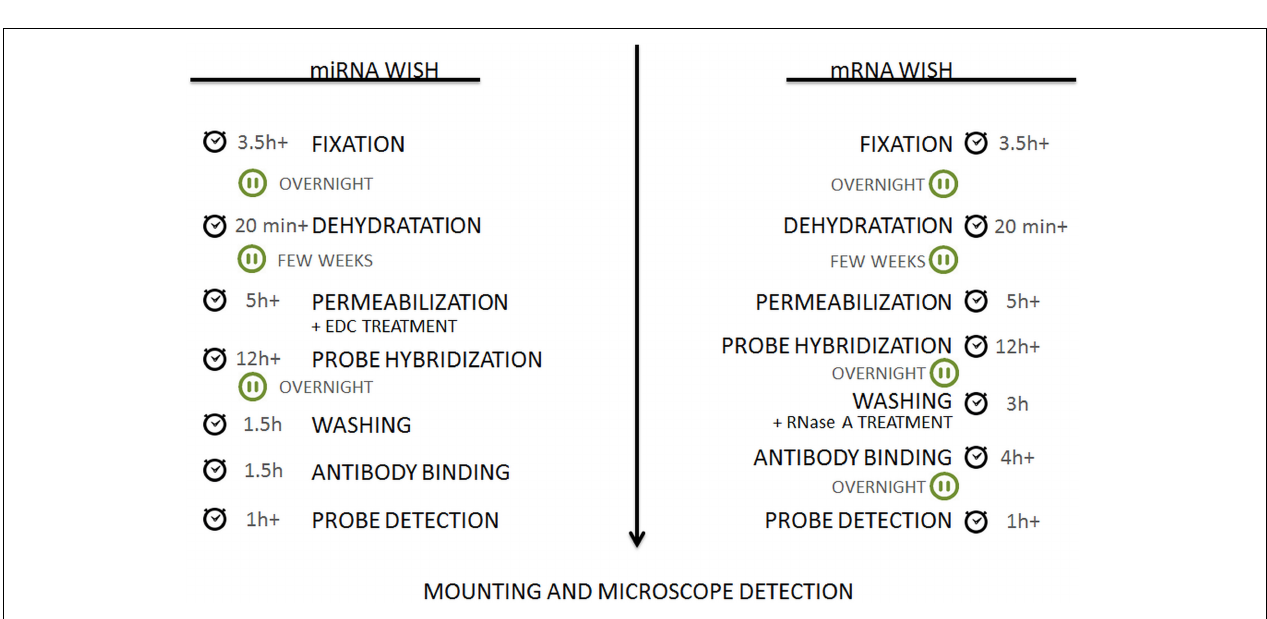
FIGURE 8 | Flow chart of the protocols. The detailed procedure can be found in the section “Material and Methods.”